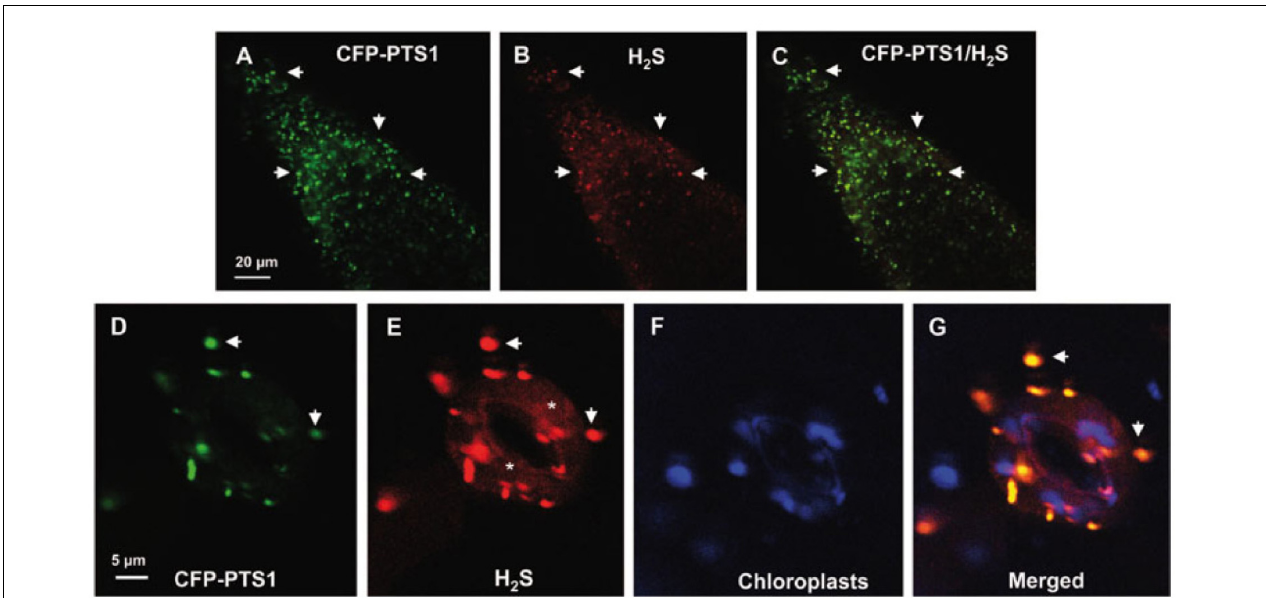
FIGURE 4 | Representative images illustrating the CLSM in vivo detection of H 2 S (red color) and peroxisomes (green color) in root tips (A–C) and guard cells (D–G) of 10 days old Arabidopsis seedlings expressing CFP-PTS1. (A,D) Fluorescence puncta (green) attributable to CFP-PTS1, indicating the localization of peroxisomes. (B,E) Fluorescence punctate (red) attributable to H 2 S detection in the same area. (C) Merged image of (A,B) showing colocalized fluorescence punctate (yellow). (F) Chlorophyll autofluorescence (blue) demonstrating location of chloroplasts. (G) Merged images of (D–F) . H 2 S (red color) was detected by using 5 mM WSP-5, a fluorescence probe for H 2 S. Arrows indicate representative punctate spots corresponding to the colocalization of H 2 S with peroxisomes. Asterisks indicate localization of H 2 S in the cytosol. Reproduced with permission from Corpas et al. (2019a) provided by John Wiley and